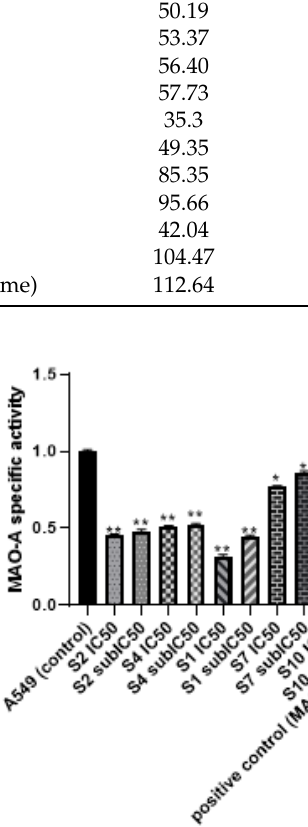
Figure 6. MAO-A activity assay. A549 cells were cultured and treated with IC 50 and sub-IC 50 of S1 , S2 , S4 , S7 , and S10 . Fluorescence detection was on Ex/Em 535/587 nm. Data were expressed as mean + SD. SD did not exceed 5%. p -value < 0.05 indicates statistical significance in-comparison to untreated control, while asterisk: ns (not-significant) p > 0.05; * p ≤ 0.05; ** p ≤ 0.01 (according to GraphPad prism